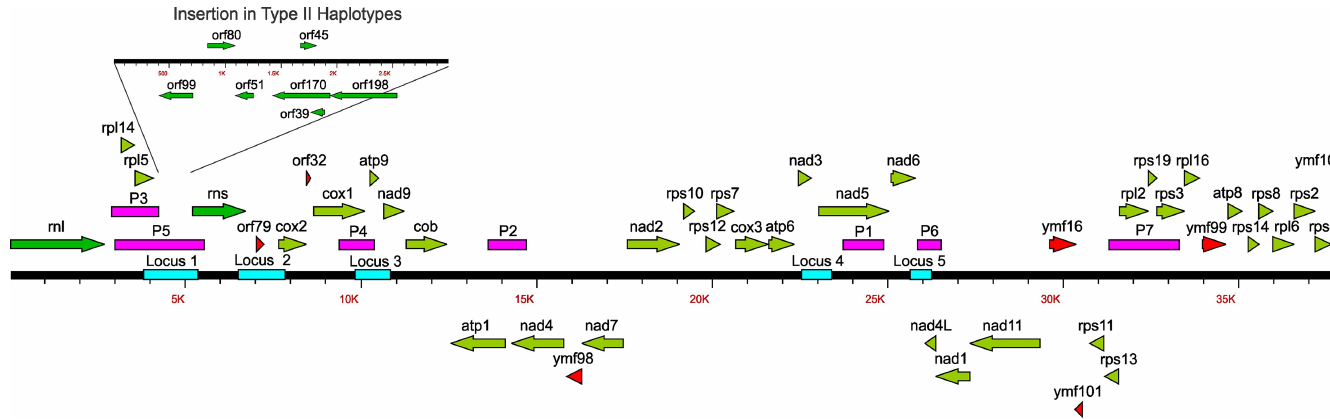
Fig 1. Linear map of the mitochondrial genome of Phytophthora infestans with the loci used for classification of mitochondrial haplotype. Regions P1 through P4 were reported by Griffith and Shaw [37] (red fill), P5 through P7 by Gavino and Fry [39] (red fill) and locus 1 through 5 (blue fill) used in this investigation.